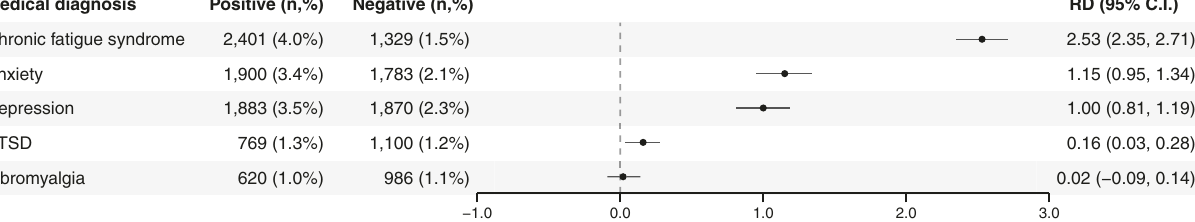
Fig. 2 Risk differences of self-reported new diagnoses received between the test date and until 6-12 months after, comparing SARS-CoV-2 test- positive and test-negative participants. Note: Bars indicate risk differences (center) with 95% con fi dence intervals (length of error bars) adjusted for age, sex, comorbidities, obesity, healthcare occupation and time after testing (in months). PTSD = post-traumatic stress disorder. For diagnoses with onset between the test date and until 6 – 12 months after the test date, all test negatives no matter of the indication for testing are used as control population. All symptom questions were mandatory, so for all lines the proportions are based on 61,002 test-positive and 91,878 test-negative individuals. An individual could only participate in the study once, as either test-positive or test negative.